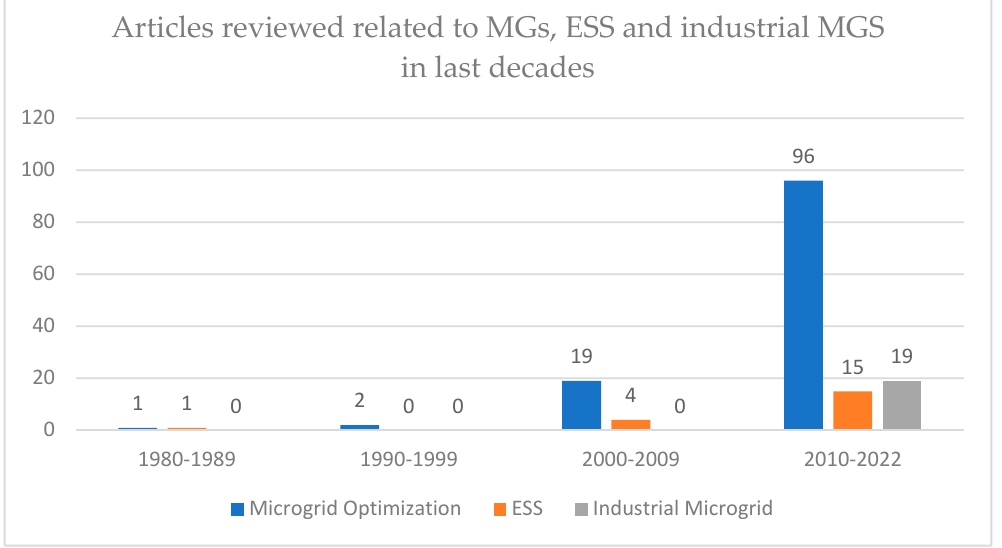
Figure 4. Articles reviewed and divided into MGs/MGs Optimization, ESS and Industrial MGs (source: own elaboration).